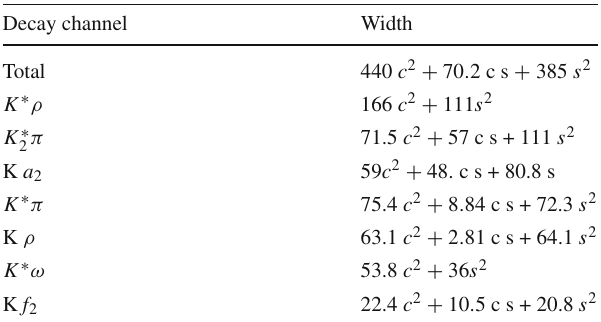
Table 8 The main strong decay widths of the K 1 ( 2 P (cid:5) ) state which as the partner of K 1 ( 1650 ) . Here, the mass of K 1 ( 2 P (cid:5) ) is taken as 1968 MeV [66]. c = cos θ 2 P and s = sin θ 2 P . The unit of the width is